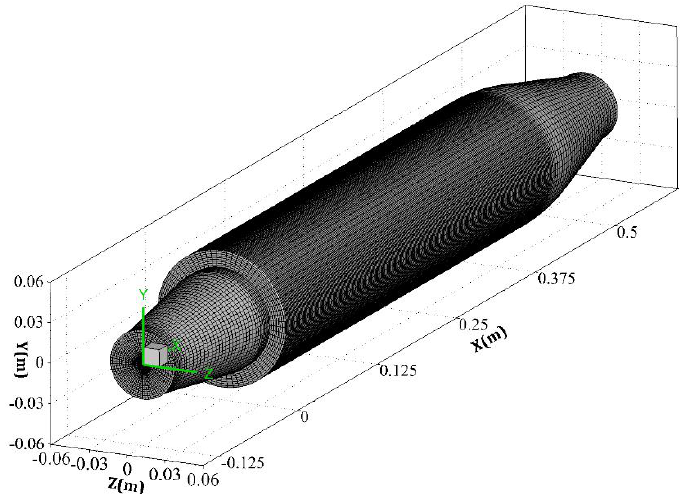
Figure 3. Discretized structured grid on model combustor’s geometry.